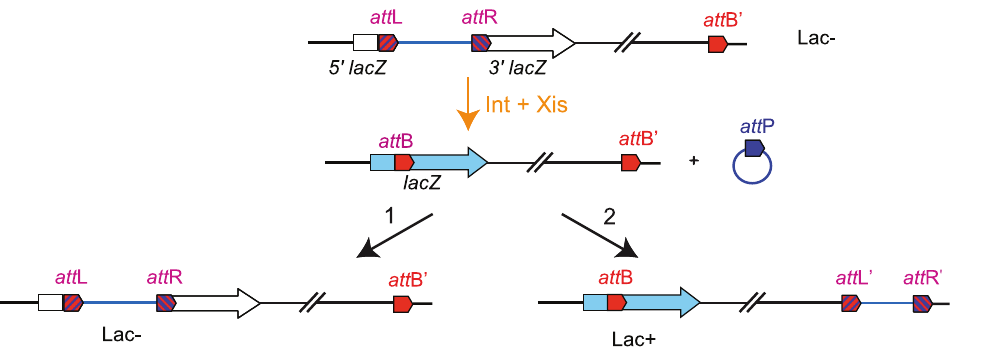
Figure 1. Chromosomal rearrangement by transposition. The three att sites are integrated in the chromosome in the same orientation. att L and att R sites are flanked by the 5 9 and 3 9 parts of lacZ , respectively [11]. An additional att B site ( att B 9 ) is inserted at a defined position. Excisive recombination promoted by Int + Xis results in the excision and circularization of the intervening segment carrying att P. This recombination event reconstitutes a functional lacZ . The excised molecule is not replicated and should be reintegrated for the viability of cells. Integration can occur in reconstituted att B (1) or in att B 9 (2). Insertion in att B 9 gives rise to Lac + recombinants.